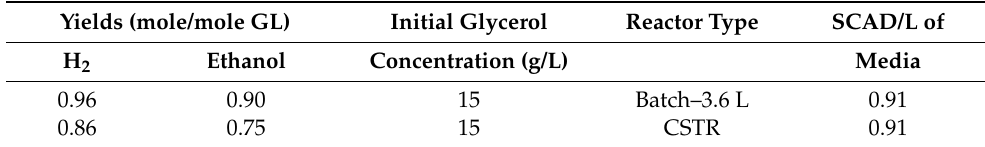
Table 4. Comparison of media cost and hydrogen and ethanol yields for the conversion of crude glycerol in batch and continuous systems using various strains of Enterobacter aerogenes . Yields (mole/mole GL) Initial Glycerol Reactor Type SCAD/L of H 2 Ethanol Concentration (g/L) Media 0.96 0.90 15 Batch–3.6 L 0.91 0.86 0.75 15 CSTR